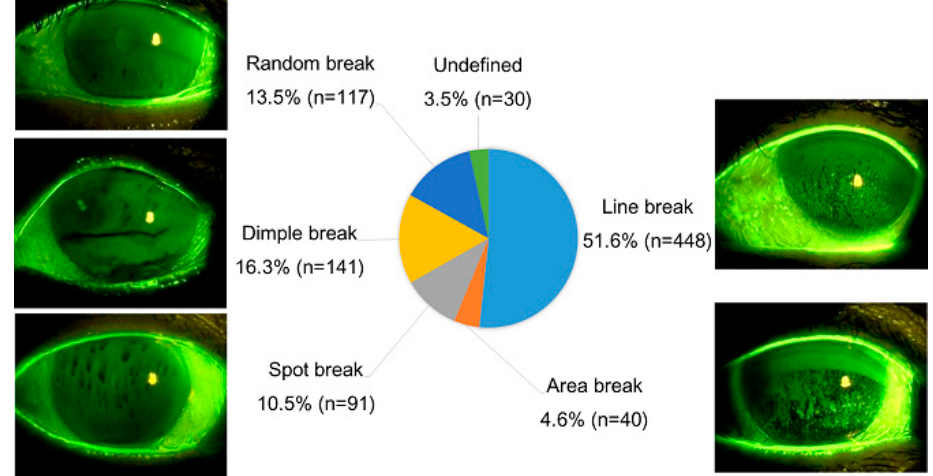
Figure 1. Distribution of fluorescein breakup patterns among dry eye patients. Among 867 eyes evaluated, approximately half (51.6%) were classified into line break.